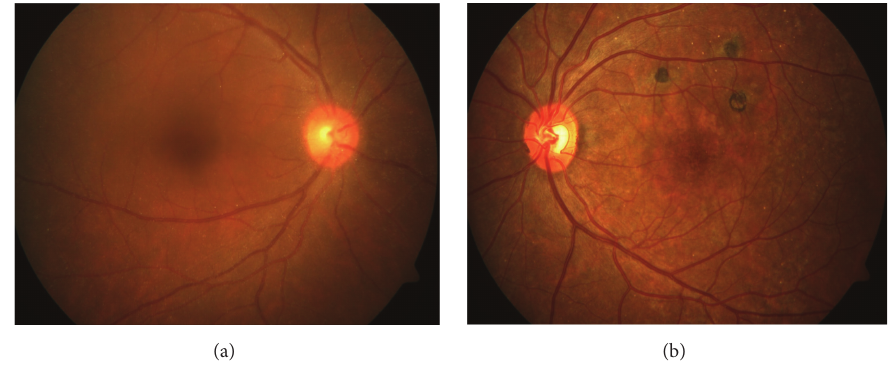
Figure 2: Fundus photograph prior to cataract surgery (right eye: (a)) showing crystal deposition over the retina. (b) Left eye for comparison.